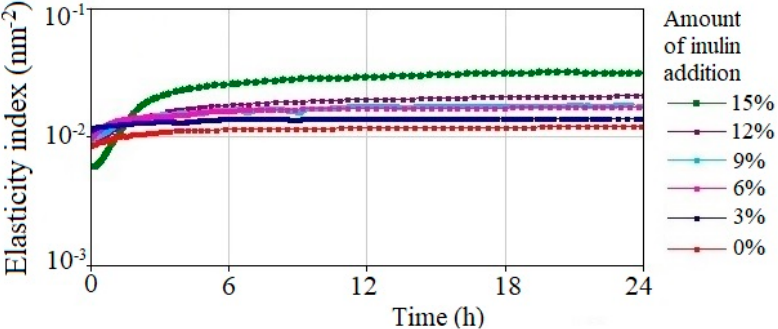
Figure 3. Elasticity indexes (EI) of yogurts with 0%, 3%, 6%, 9%, 12% or 15% w/w inulin addition during 24 h stabilization at 20 °C.